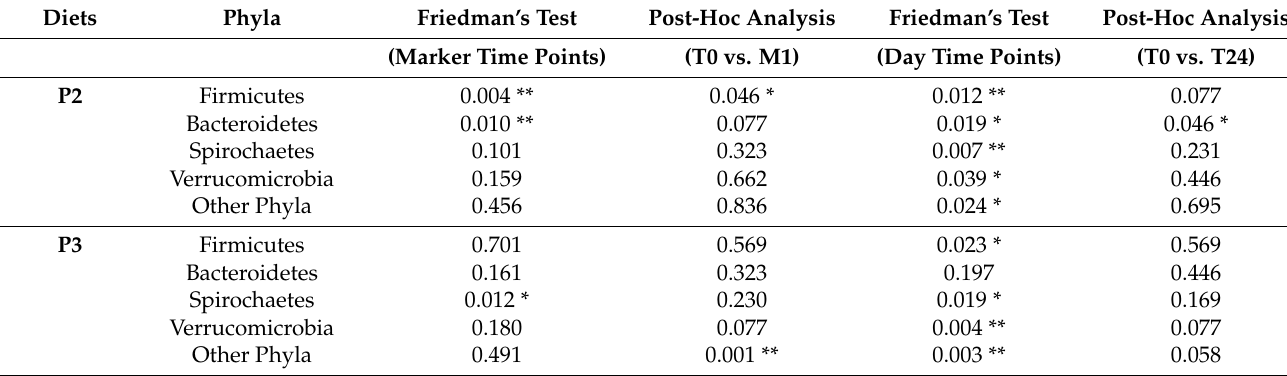
Figure 5. Comparison of the four most dominant phyla with transit time of digesta (T0, M1, M25, M50 and M75) in horses ( n = 6) across the forage-based diets included in the study. Relative abundances of the four most dominant phyla and remaining phyla (Other Phyla) that comprise the faecal bacterial community of horses included in the study are shown in the stacked bar graphs. The sequence of the stacked bars along the x-axis in each panel is: T0 (time 0 when the diet was changed, and markers administered); M1 (time when the first intestinal marker was retrieved in the faeces); M25 (time when 25% of the intestinal markers were retrieved in the faeces); M50 (time when 50% of the intestinal markers were retrieved in the faeces); and M75 (time when 75% of the intestinal markers were retrieved in the faeces). The time points in hours following dietary change are shown on the x-axis of each graph panel and the relative abundance of the phyla as percentage are shown on the y-axis. The diets are labelled as Diet P2 - cut pasture fed during week 3; Diet P3 - cut pasture fed during week 5; Diet FE - chopped ensiled Lucerne and Timothy; Diet FE + O - chopped ensiled Lucerne and Timothy fed with whole oats; and Diet H + O - hay fed with whole oats. Table 4. p -Values for differences between the most dominant phyla across time